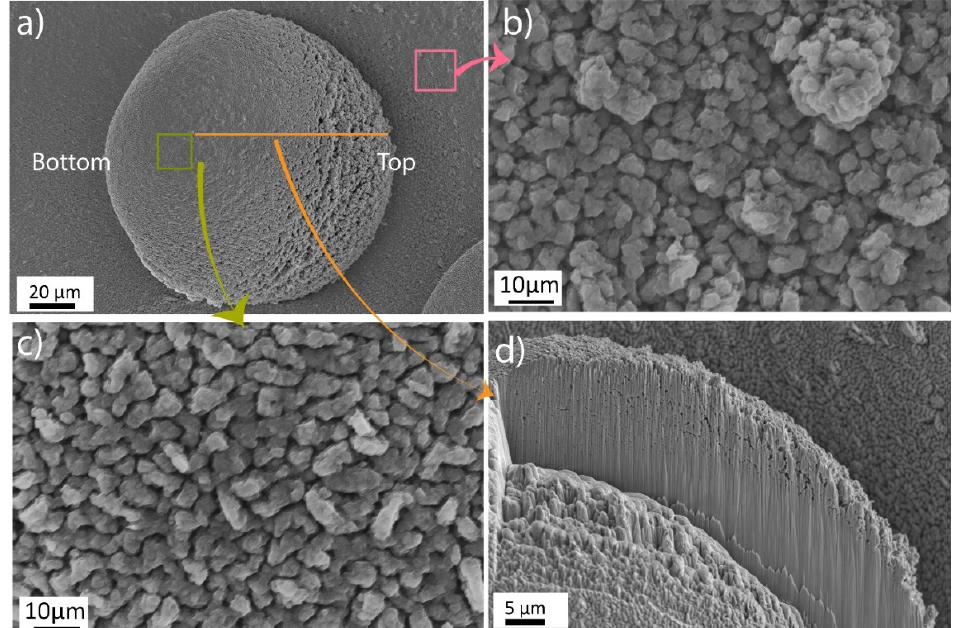
Figure 3. Morphological analysis of ( a ) spatter particle deposited on the heat shield surface and high-magnification micrographs of ( b ) condensate on the surface shield, ( c ) spatter particle surface, and ( d ) FIB cross-section of spatter particle.